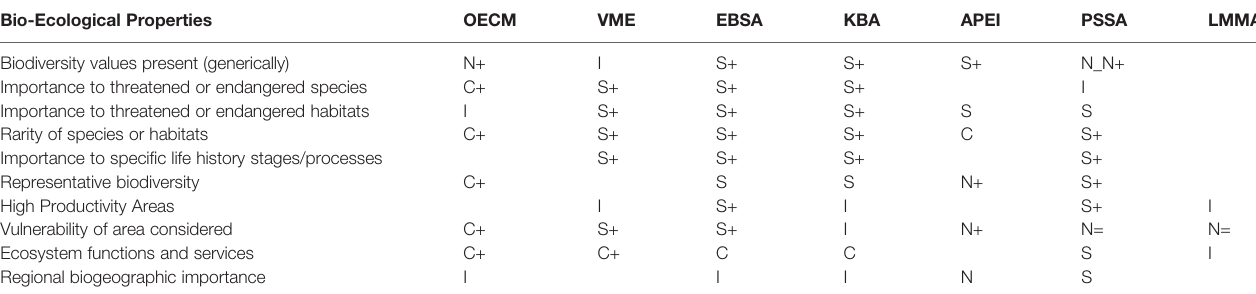
TABLE 2 | Biological and Ecological Properties tabulated by explicitness and clarity of inclusion inthe foundation documents for each acronym. Scores and abbreviations explained in Table 1 . Bio-Ecological